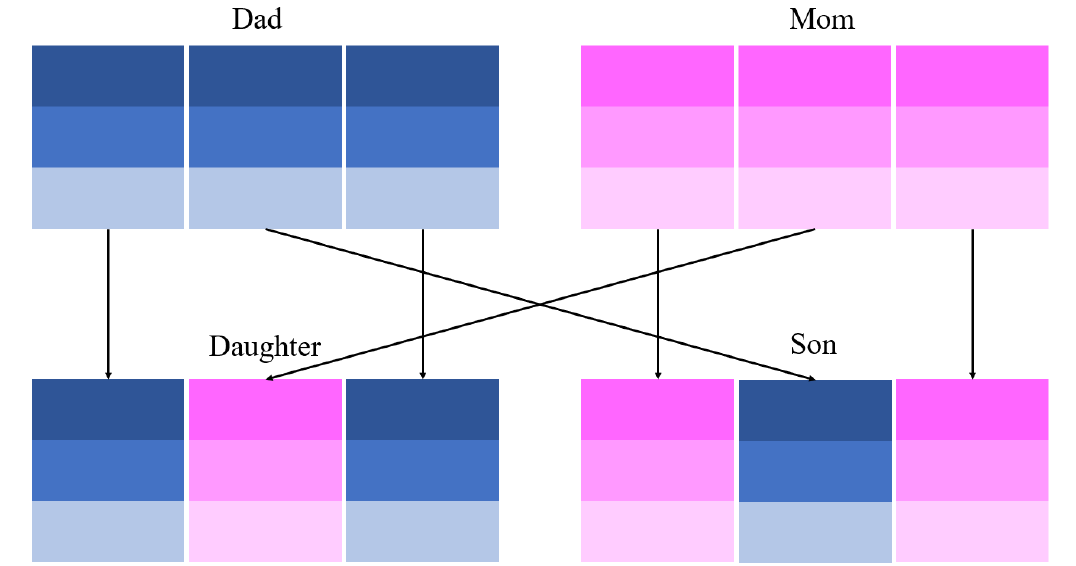
Figure 6. Graphical representation of the crossovergenetic operator in the